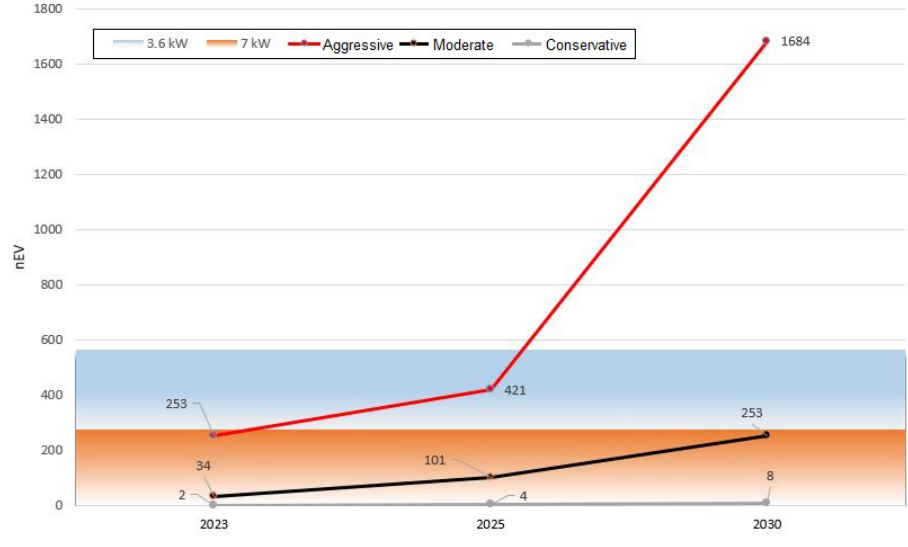
Figure 14. Projection—Feeder